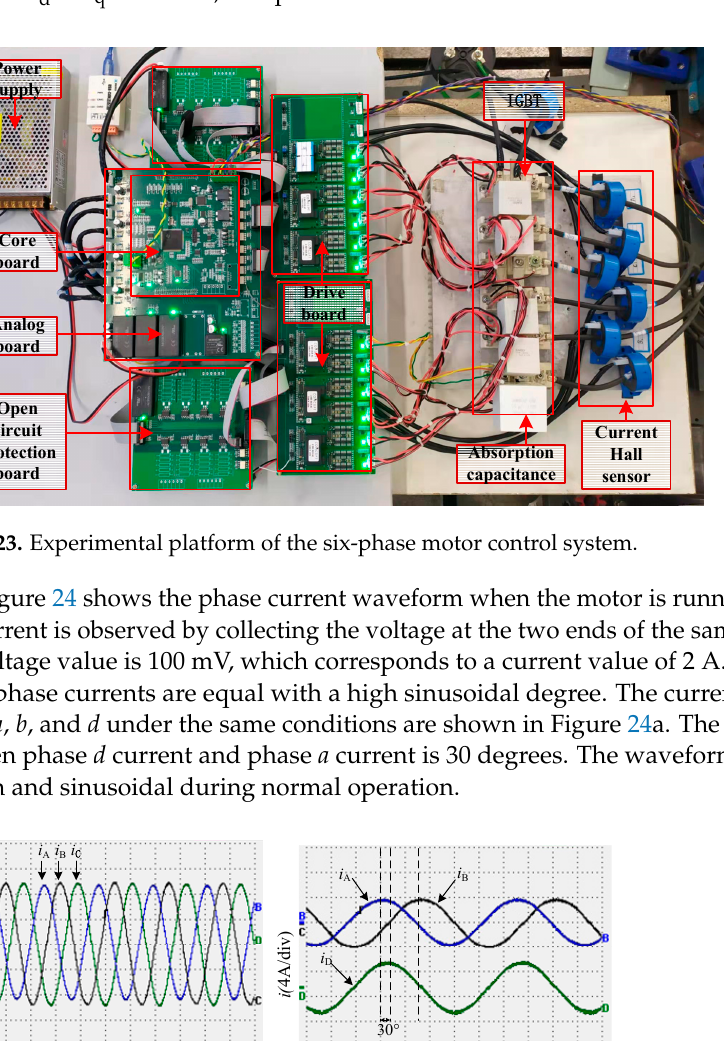
Figure 22. Overall block diagram of the six-phase PMSM control system.